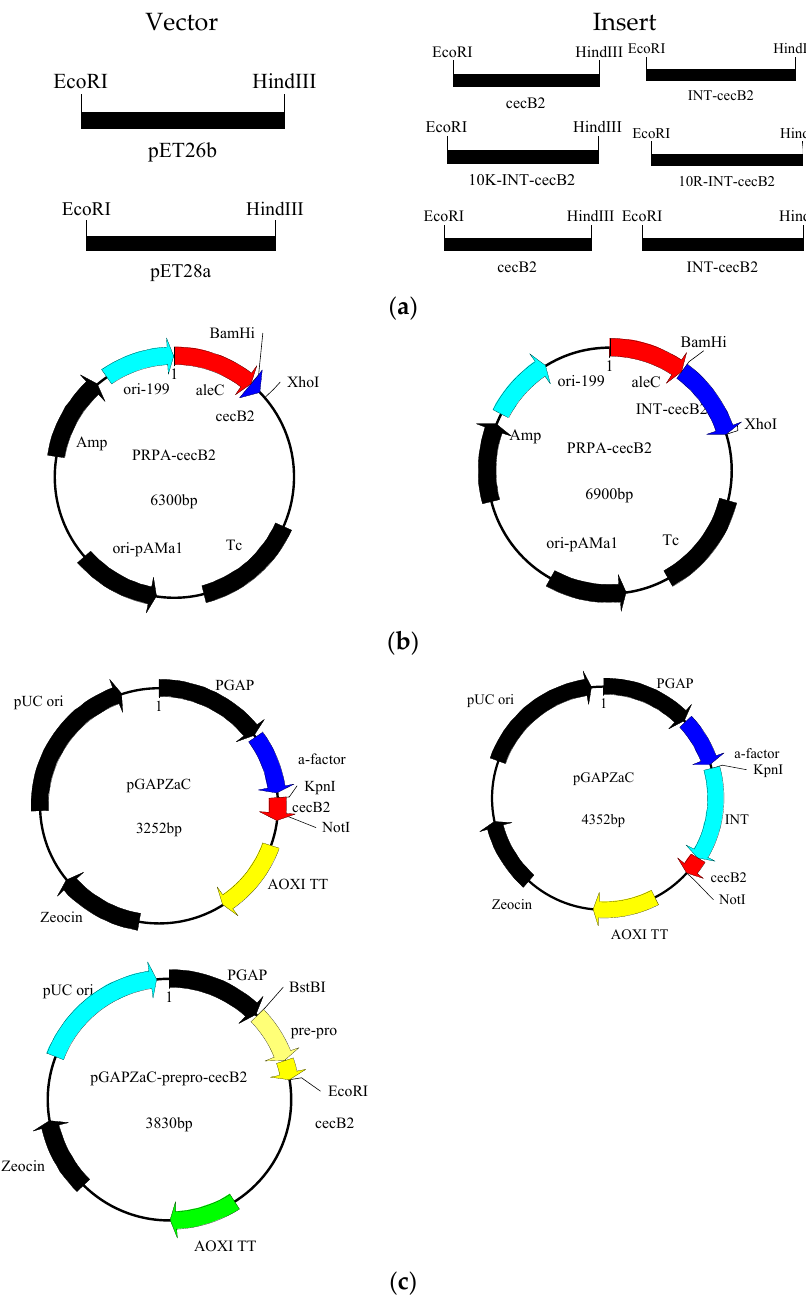
Figure 4. Plasmid constructs in this study. ( a ) Plasmid constructs in E. coli ; ( b ) Plasmid constructs in B. subtilis ; ( c ) Plasmid constructs in P. pastoris .